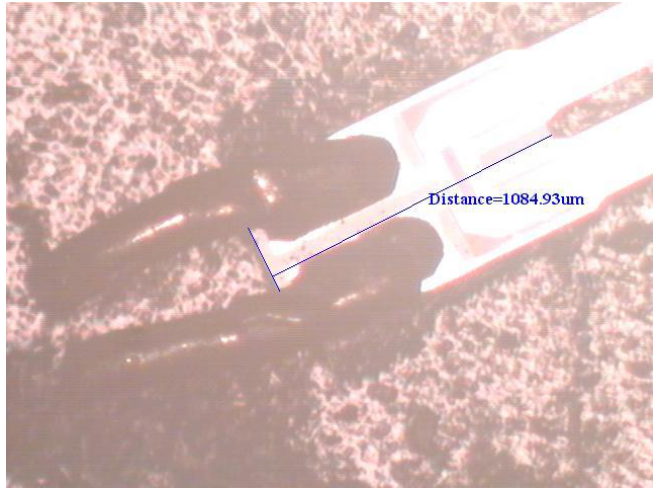
Figure 16. Determination of the length of the proof mass from a microscope image.